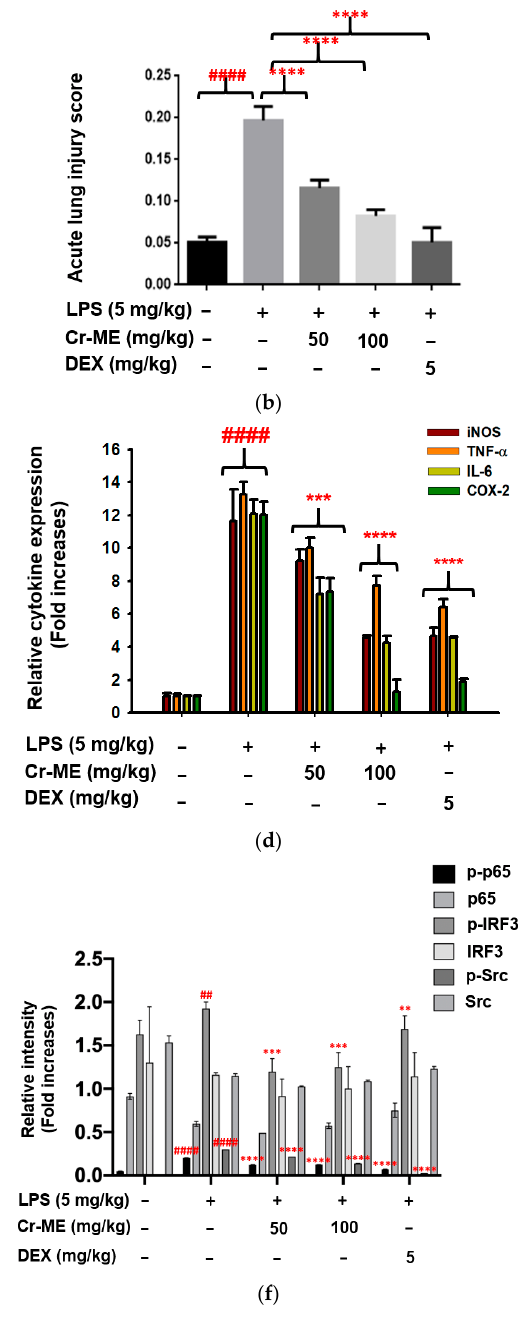
Figure 5. Effect of Cr-ME treatment on LPS-induced acute lung injury (ALI). ( a , b ) Histological analysis was performed to visualize the inhibitory activity of Cr-ME in LPS-induced acute lung injury conditions of mice after 16 h of LPS instillation ( a ). H&E stain was applied to the sections, original magnification, 200×. Acute lung injury scores were calculated according to parameters indicated in Table 1 ( b ). (c) The effect of Cr-ME on pulmonary edema was determined by calculating the lung wet/dry weight ratio. ( d ) The mRNA expression levels of inflammatory genes were determined by real-time PCR. ( e , f ) The total and phospho-forms of p65, IRF3, Src, and β -actin were analyzed by Western blotting analysis performed with tissue lysates from the LPS-induced ALI mice ( e ). Relative intensity of these proteins was calculated by ImageJ ( f ). All the data ( b – d , f ) expressed as the mean ± SD of 7 mice or three independent experiments. Relative band intensity was measured using ImageJ Values are mean ± SD ( n = 5 per group). Statistical significance was calculated using one-way ANOVA (Dunnett’s t -test). # p < 0.05, ## p < 0.001, and #### p < 0.0001 compared to normal group, * p < 0.05, ** p < 0.01, *** p < 0.001, and **** p < 0.0001 compared to LPS group.